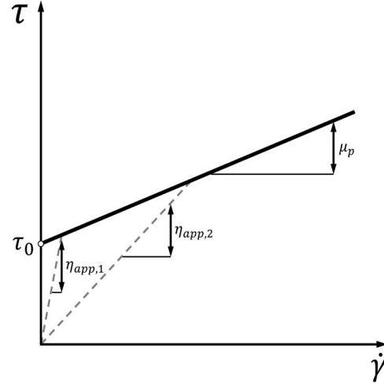
Flow curve according to Bingham, with a visualisation of apparent and plastic viscosity.